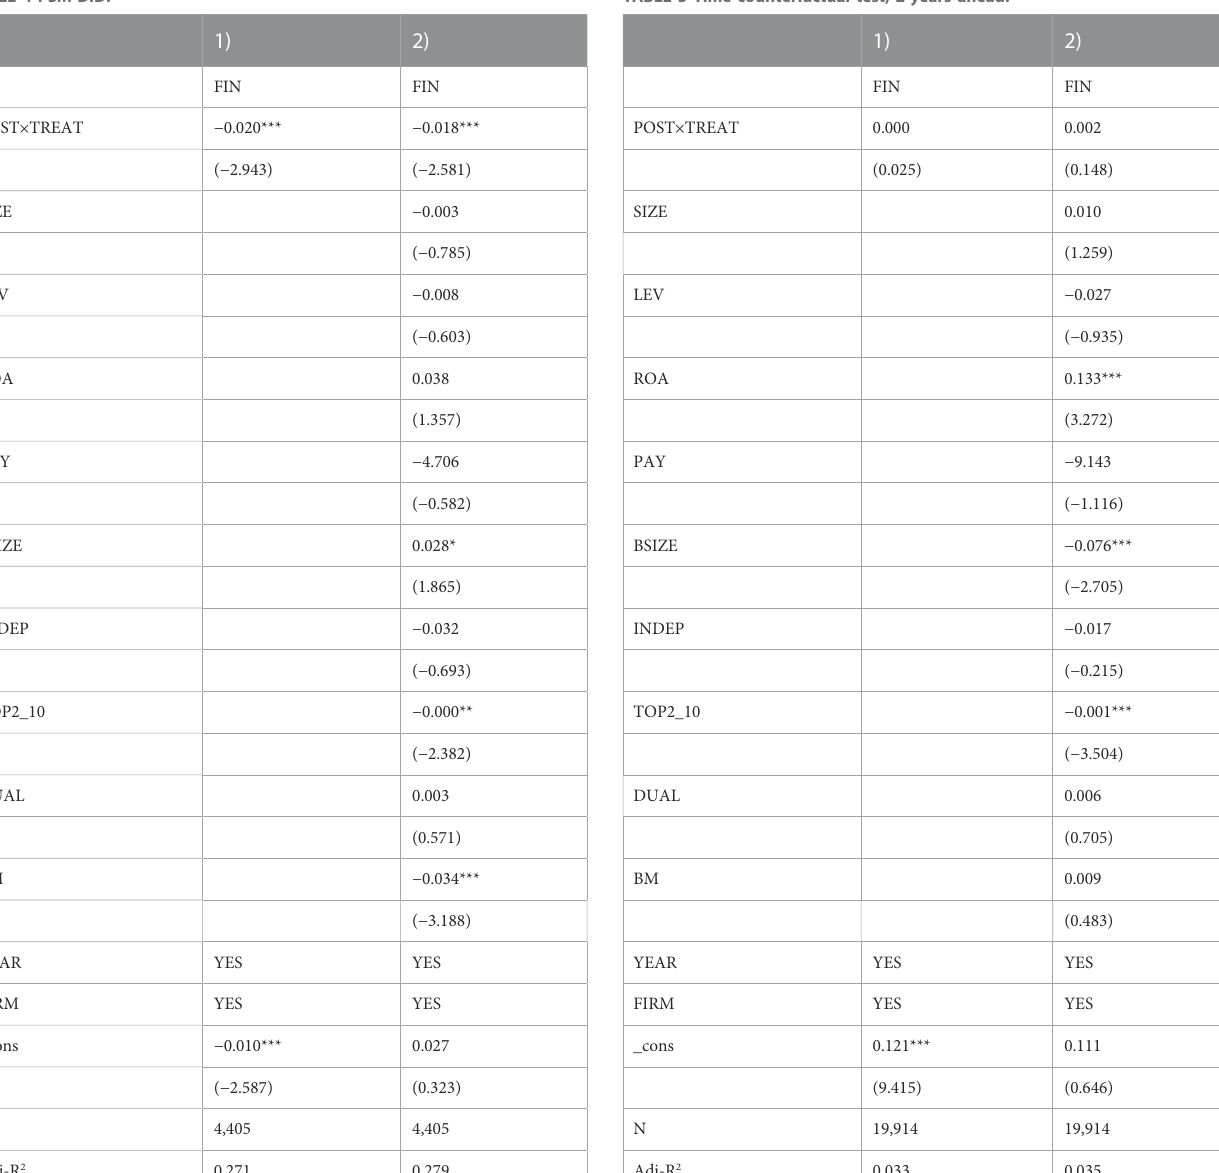
TABLE 5 Time counterfactual test, 2 years